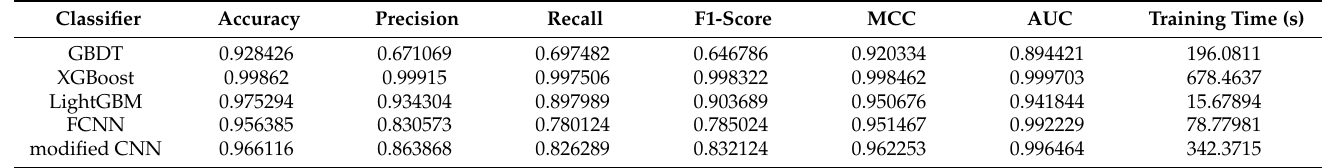
Table 2. Accuracy, precision, recall, F1 score, MCC, AUC and training time for every classifier on the actual UAV data.